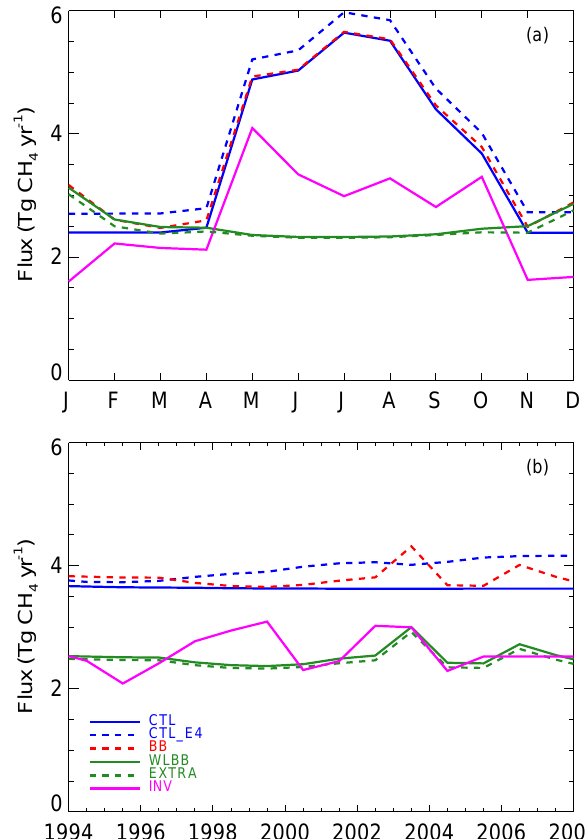
Figure 3. Seasonal cycle (a) and annual mean (b) methane fluxes for 1994–2007 integrated over the SE Australian region (135– 155 ◦ E, 30–45 ◦ S). Six flux scenarios are shown as listed in the